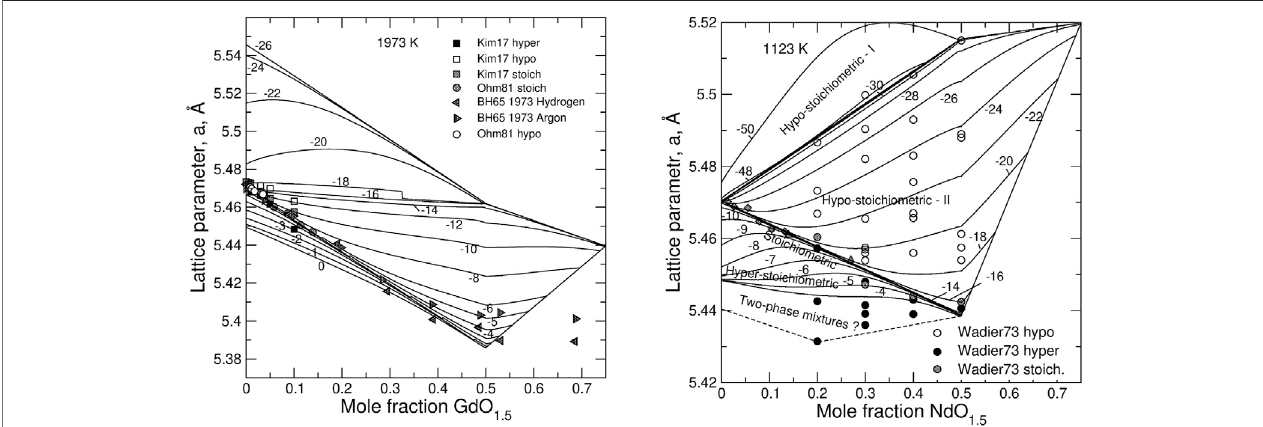
FIGURE 7 | Relationship between the lattice parameter and the degree of doping, z , in GdO 1.5 — UO 2 (left) and NdO 1.5 – UO 2 (right) systems. Solid lines are calculatedwiththemodelisoplethsofconstantlog ( P O / P 0 ) .Dashedlinesschematicallyoutlinethetwo-phase fi eld,where fl uoritesolidsolutionlikelycoexistswithU 4 O 9 - 2 type solid solution. The fl uorite phase is subdivided into three fi elds which correspond to hypostoichiometric I, hypo-stoichiometric II and hyper-stoichiometric solid solutions for which different models are implemented. The hypo-stoichiometric type-II fi eld is further subdivided into II,a and II,b areas by the line z (cid:1) 0.5. The experimental data are from Kim et al. (Kim et al., 2017), Ohmichi et al. (Ohmichi et al., 1981), Beals and Handwerk (Beals and Handwerk, 1965), Wadier (Wadier, 1973). The data falling outside the quadrilateral possibly indicate the need of including of U +6 states into the model and/or the need of taking into account the presence of an additional phase.